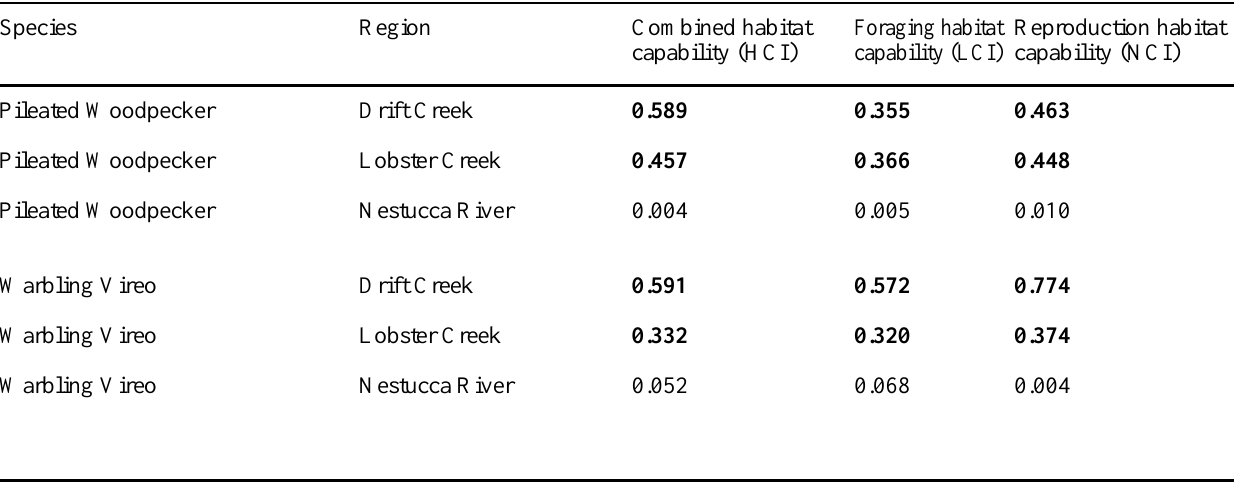
Table 2. Regression coefficients ( R 2 ) between independent field data (McGarigal and McComb 1995) collected in three regions of the Oregon Coast Range ( n =10,250 sub-basins in each region) and calculated HCI scores for two focal species. Values in bold are significant at P